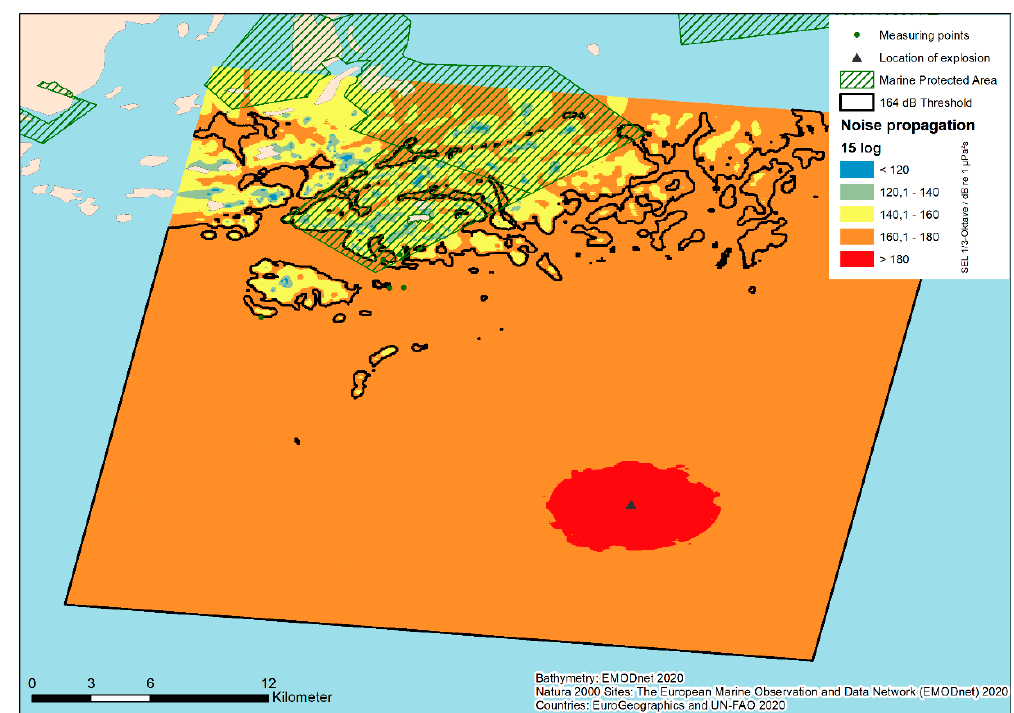
Figure A5. Sound exposure level map using 15 log law with consideration of the bathymetry.